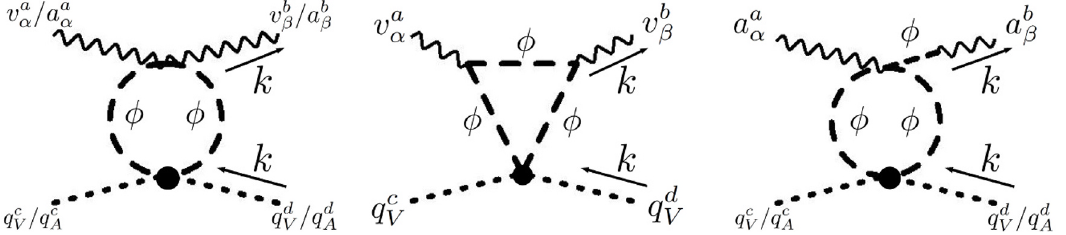
Figure 4 . Contributions from meson loops. The black circle denotes the O ( e 2 ) vertex. The third diagram contains a meson